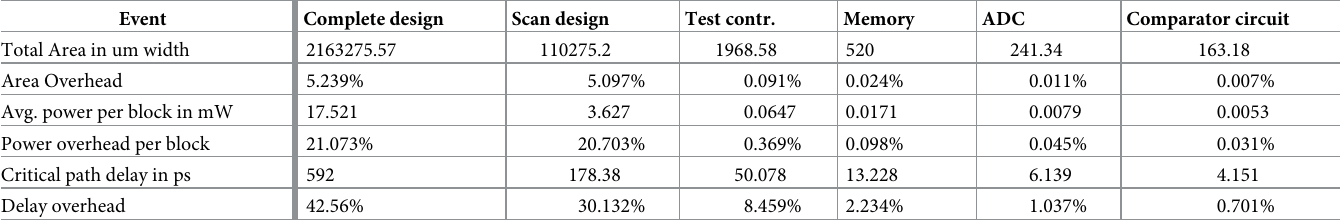
Table 2. A detailed result of hardware overhead, power and delay with and without scan